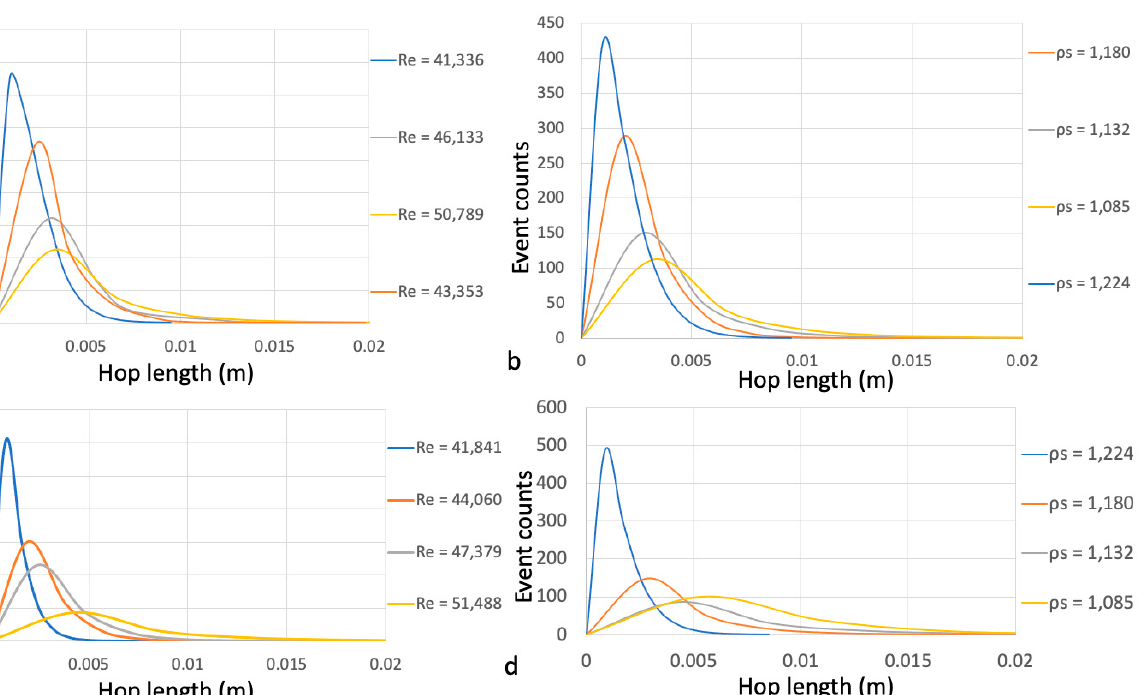
Figure 12. Mean hop distance travelled, for different instrumented particle densities: ( a ) against Reynolds number, for bed surface A, ( b ) against Reynolds number, for bed surface B, ( c ) against Reynolds number, for bed surface A, and ( d ) against Reynolds number, for bed surface B.